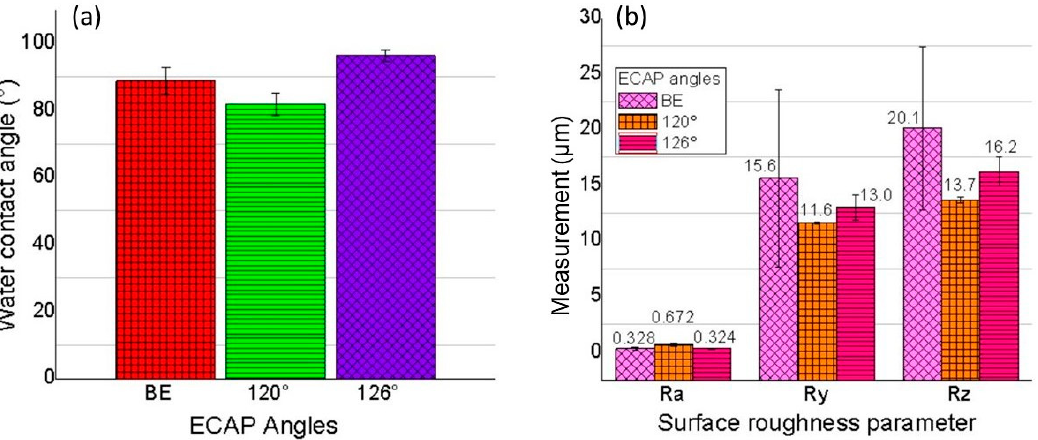
Figure 6. ( a ) Contact angle and ( b ) surface roughness properties of SS316L before and after